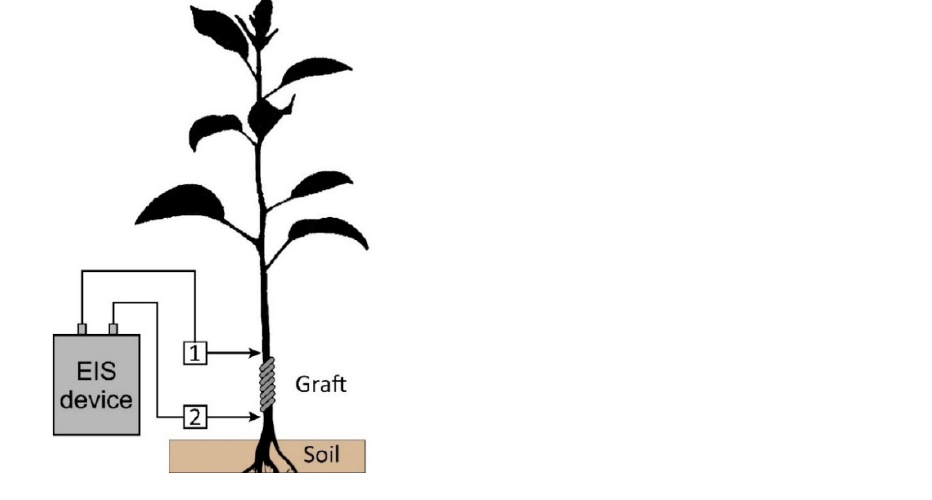
Figure 12. Measurement of the electrical impedance of the graft zone in an apple seedling 6 months after grafting. 1, 2—electrodes located at a distance of 80 ± 5 mm from each other.